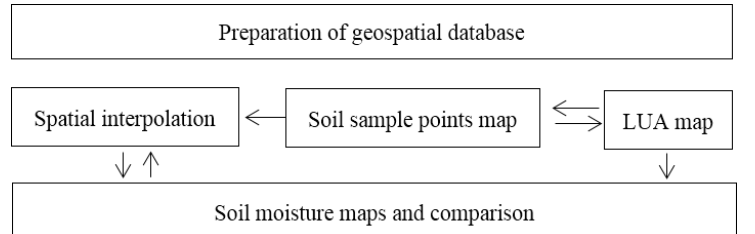
Figure 5. The main steps of geospatial database creating, LUA map, and spatial interpolation methods in GIS to produce the SM map.